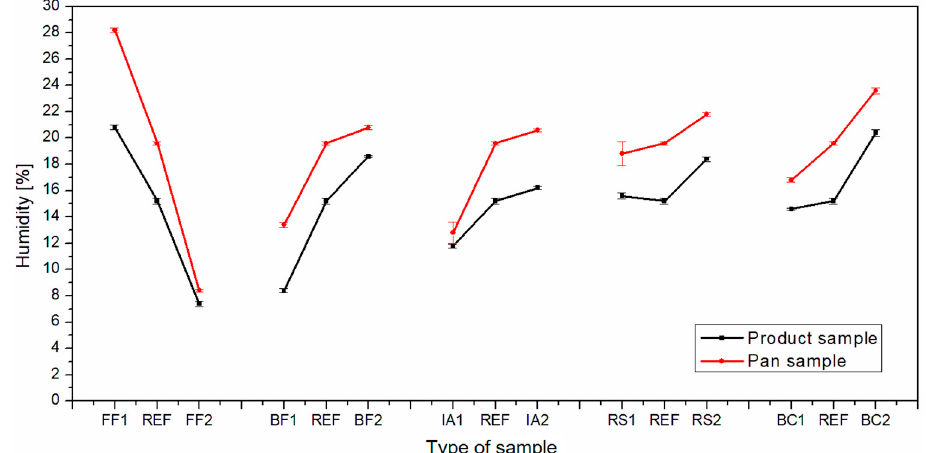
Figure 16. Influence of the operating parameters on the humidity.